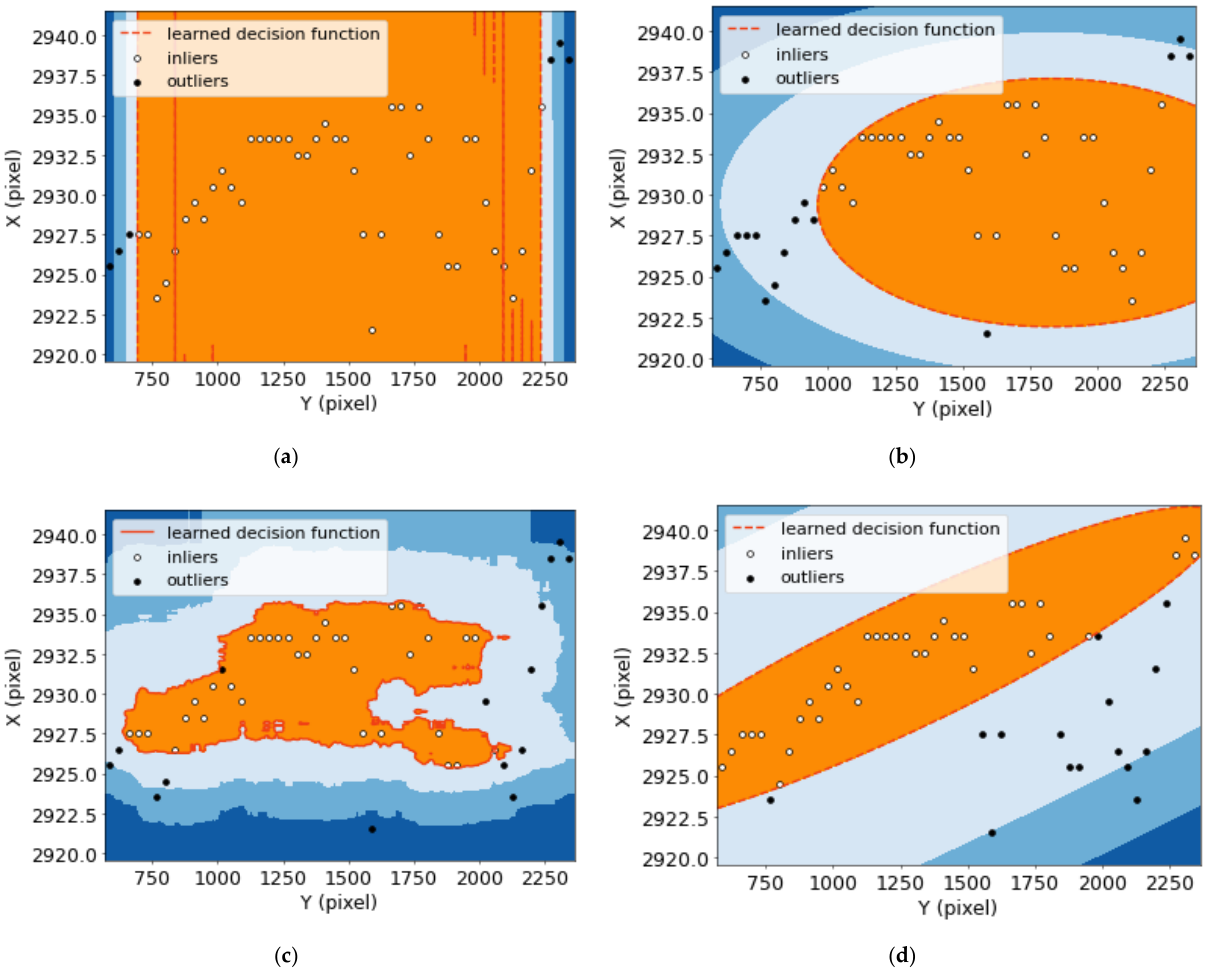
Figure 13. Effectiveness of several usual outlier detection algorithms on sample feature points: ( a ) KNN; ( b ) PCA; ( c ) isolate forest; ( d ) MCD.